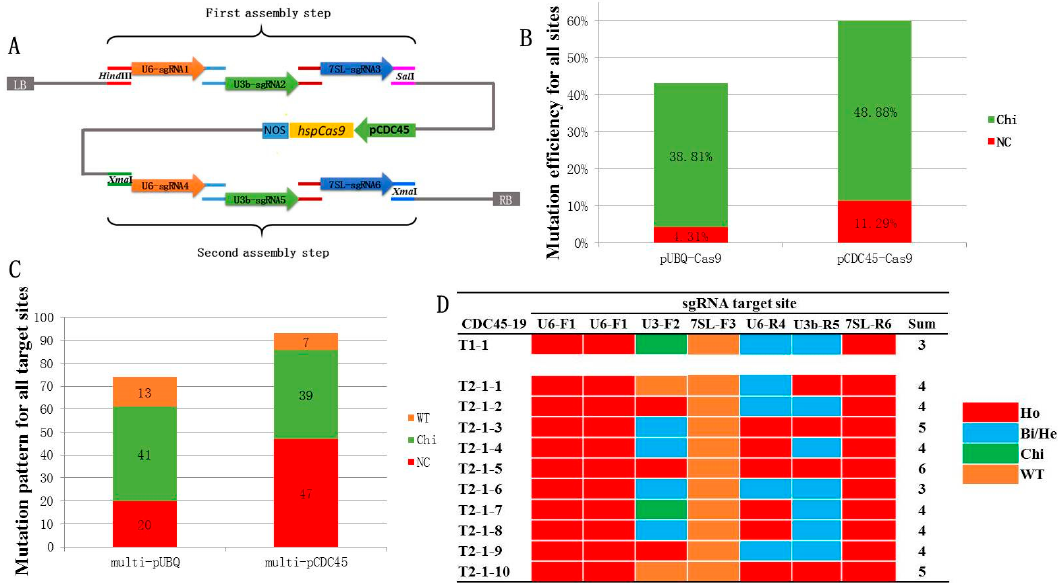
Figure 2. pCDC45-Cas9 system for multiplex gene editing in Arabidopsis . ( A ) Schematic diagram of the multi-pCDC45-Cas9 construct. Up to six single guide RNA (sgRNA) fragments with 15 to 20 bp of overlapped sequences were assembled into the pCDC45-Cas9 binary vector by homologous recombination in two steps (3sgRNAs + 3sgRNAs). ( B ) Mutation frequencies and nonchimeric mutation ratios for the multi-pUBQ-Cas9 and multi-pCDC45-Cas9 systems in the T1 generation. For the multi-pUBQ-Cas9 system, 74 target sites were tested by Sanger sequencing while 93 target sites were tested for the multi-pCDC45-Cas9 system. The mutation frequencies were calculated in each target site, and the average of all data used for the two multiplex CRISPR/Cas9 systems. ( C ) Mutation patterns for all target sites for the two multiplex CRISPR/Cas9 systems in the T1 generation. NC: Nonchimeric mutations (homozygous, bi-allelic, heterozygous), Chi: chimera; WT: wild type. ( D ) Zygosity of mutations induced by the CDC45-19 construct in 10 T2 plants from a single T1 line. Sum: The number of target genes with homozygous mutation in individual plants. Ho: homozygous; He: heterozygous; He/Bi: heterozygous/bi-allelic; Chi: chimera; WT: wild type.